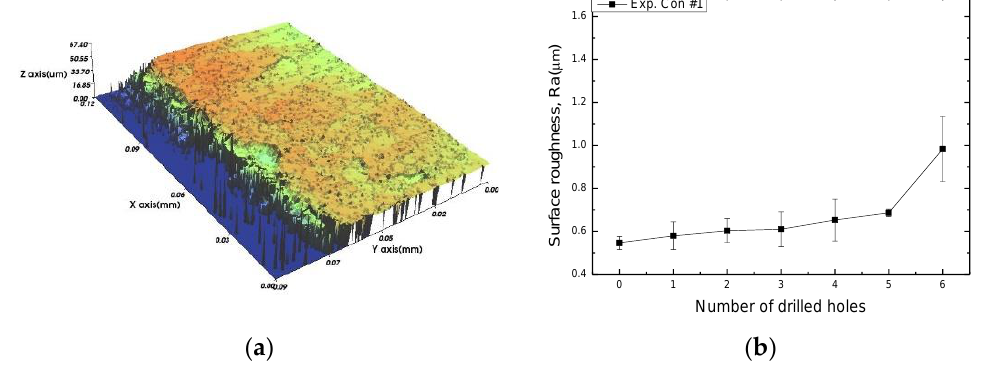
Figure 5. Surface roughness of the outer corner of the drill bit as shown in Figure 3: ( a ) three-dimensional surface image before drill bit breakage (after drilling the 6th hole); ( b ) surface roughness of the outer corner of the drill bit as a function of the number of drill holes.